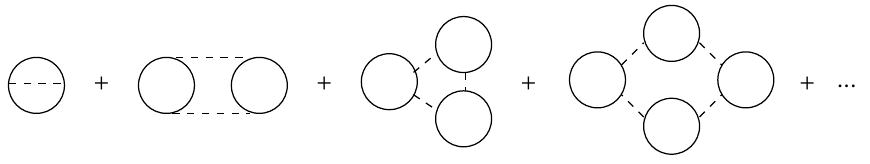
Figure 4 . The next-to-leading order contribution of the large- N expansion in the O ( N ) model. vertices (e.g. the graph in (cid:12)gure 2; see [52] for more details). Such graphs lead again to an action term which is quadratic in (cid:30) , thus not a(cid:11)ecting the existence of the (cid:30) = 0